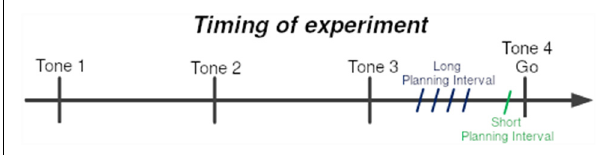
FIGURE 2 | Timing of experiment. Subjects were trained to leave the starting point at the last of sequence of four tones at 700 ms intervals. The 4th tone constituted the Go signal. One of the four targets was presented prior to the Go signal by either the Short-planning interval of 25 ms or the Long-planning interval of 250, 350, 450, or 550 ms. The four Long-preparation intervals were presented in four different blocks of